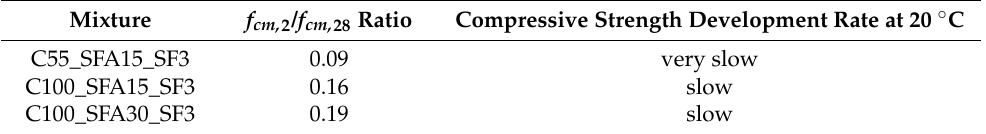
Table 4. Rate of compressive strength development for HPC mixtures according to EN 206. Mixture f cm, 2 / f cm, 28 Ratio Compressive Strength Development Rate at 20 ◦ C C55_SFA15_SF3 0.09 very slow C100_SFA15_SF3 0.16 C100_SFA30_SF3 0.19